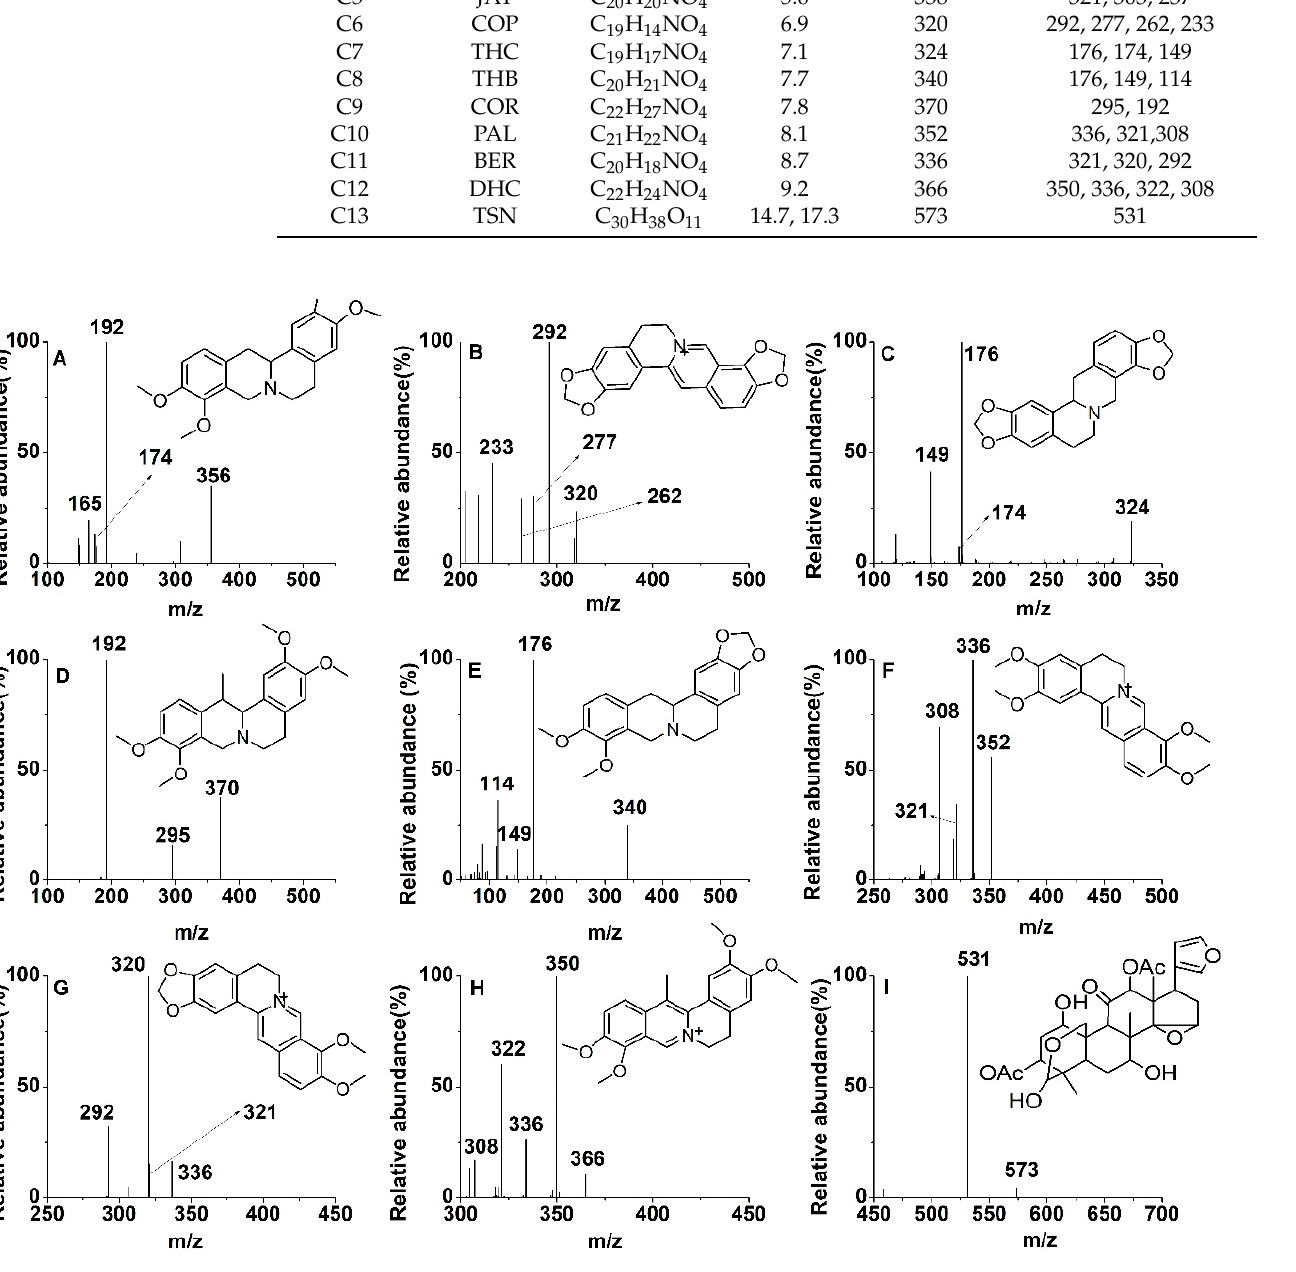
Figure 5. Product ion (MS 2 ) spectra and chemical structures of tetrahydropalmatine (THP) ( A ), coptisine (COP) ( B ), tetrahydrocoptisine (THC) ( C ), corydaline (COR) ( D ), tetrahydroberberine (THB) ( E ), palmatine (PAL) ( F ), berberine (BER) ( G ), dehydrocorydaline (DHC) ( H ), and toosendanin (TSN) ( I ).